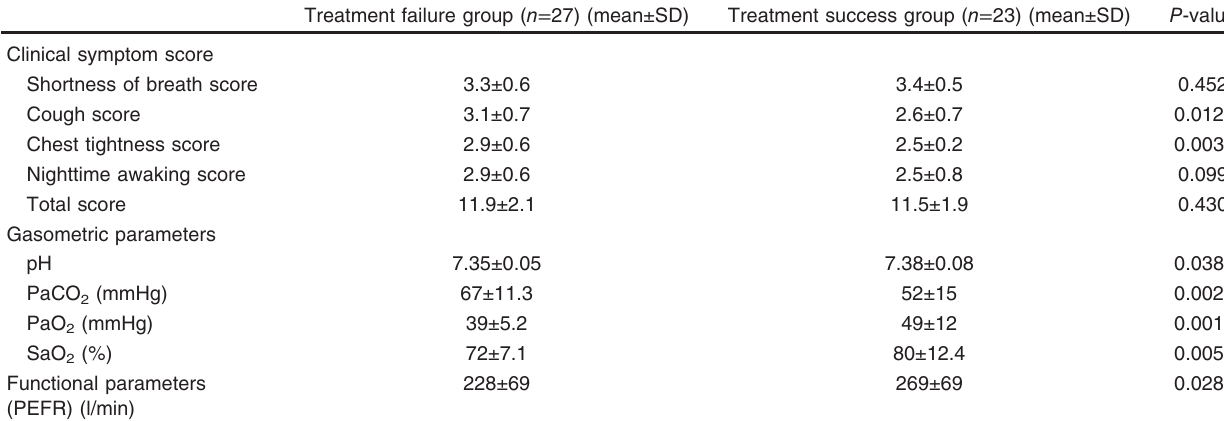
Table 2 Baseline clinical, gasometric, and functional parameters of treatment failure and treatment success groups among chronic obstructive pulmonary disease patients Treatment failure group ( n = 27)